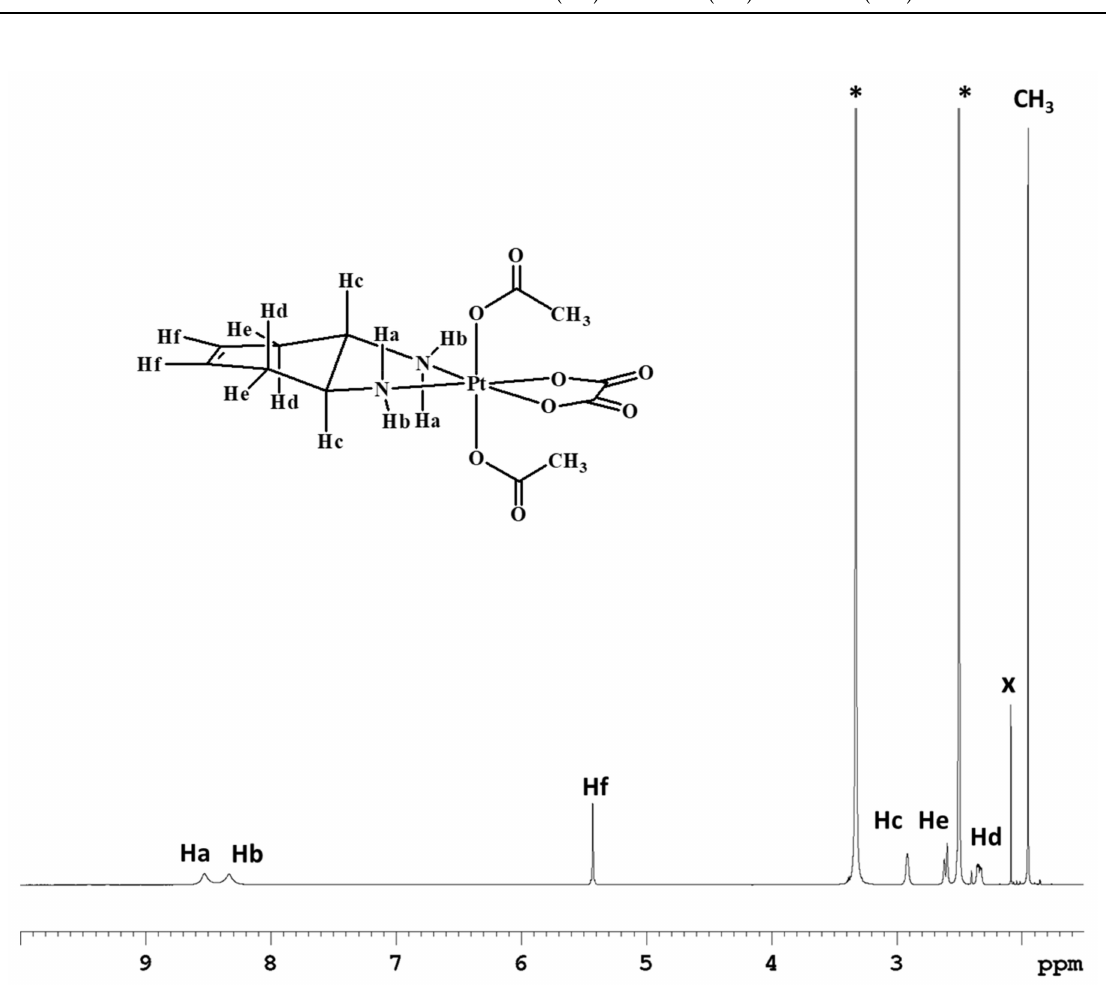
Figure 2. 1 H-NMR spectrum (700 MHz, 1 H) of 2 in DMSO-d 6. * indicates solvent residual peaks, x indicates an impurity (acetone) present in the